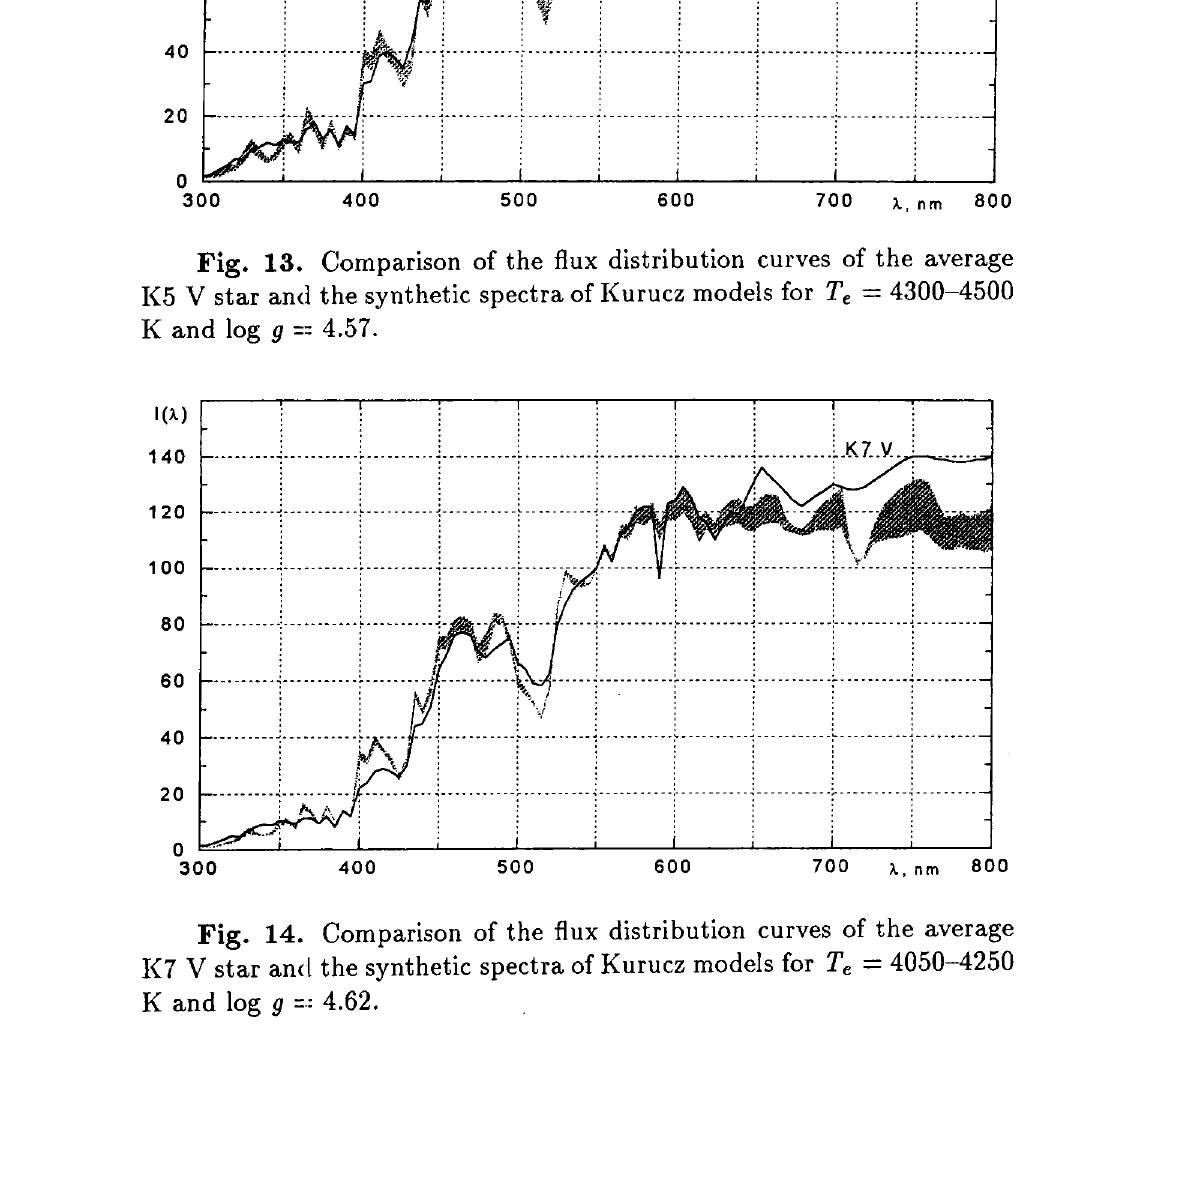
Fig. 14. Comparison of the flux distribution curves of the average K7 V star and the synthetic spectra of Kurucz models for T K and log g